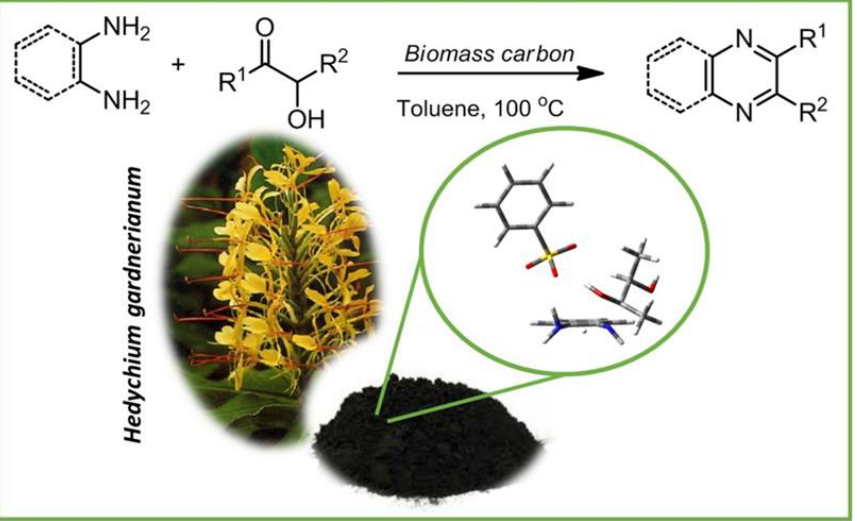
Figure 26. Acid biomass-derived carbons from Hedychium gardnerianum biomass efficiently catalyze the synthesis of quinoxalines. Adapted with permission from ref. [132].